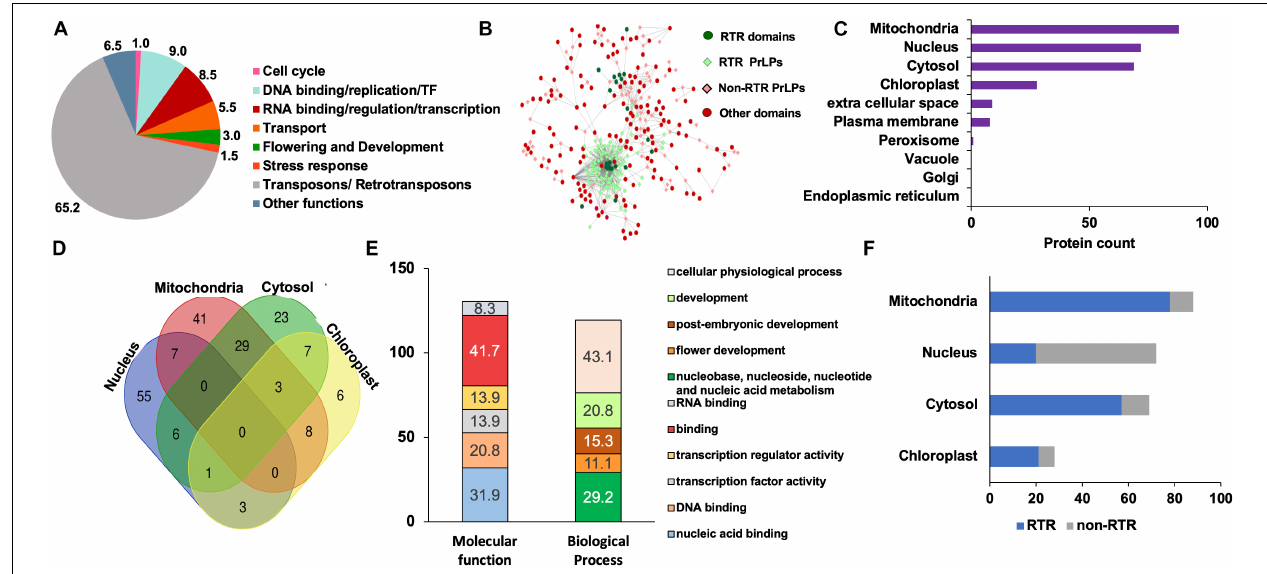
FIGURE 2 | Rice prionome has a preponderance of transposon/retrotransposon (Ts/RTR) type of PrLPs and participates in diverse functions of the cell with organellar enrichment of specific functions. (A) Functional classification. (B) Visualization of domain categories including transposons/retrotransposons (Ts/RTRs) (dark green circles) in Ts/RTRs PrLP candidates (light green diamonds), other domains (red circles) in non-Ts/RTR PrLPs (light pink diamonds). (C) Organelle-based distribution. (D) Venn diagram depicting the overlapping distribution of PrLPs in top four organelles. (E) Gene ontology- (GO-) based classification of nucleus localized rice PrLPs. (F) Percentage distribution of Ts/RTRs and non-Ts/RTRs in different